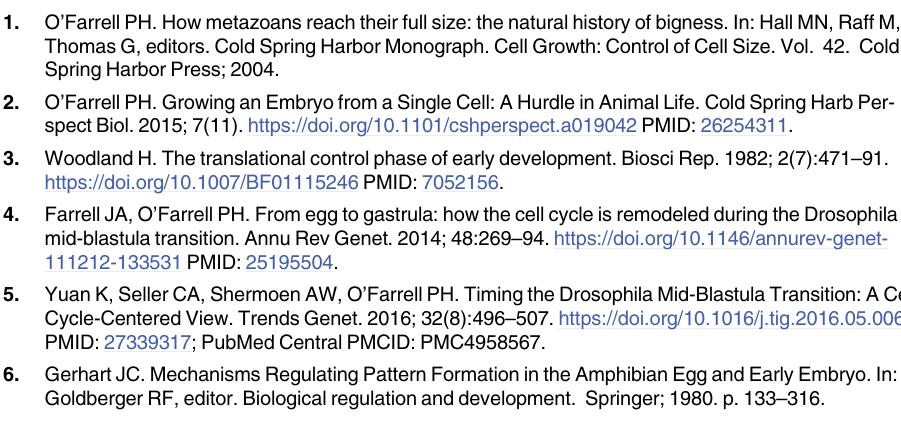
S1 Raw Image. Uncropped immunoblot image for Fig